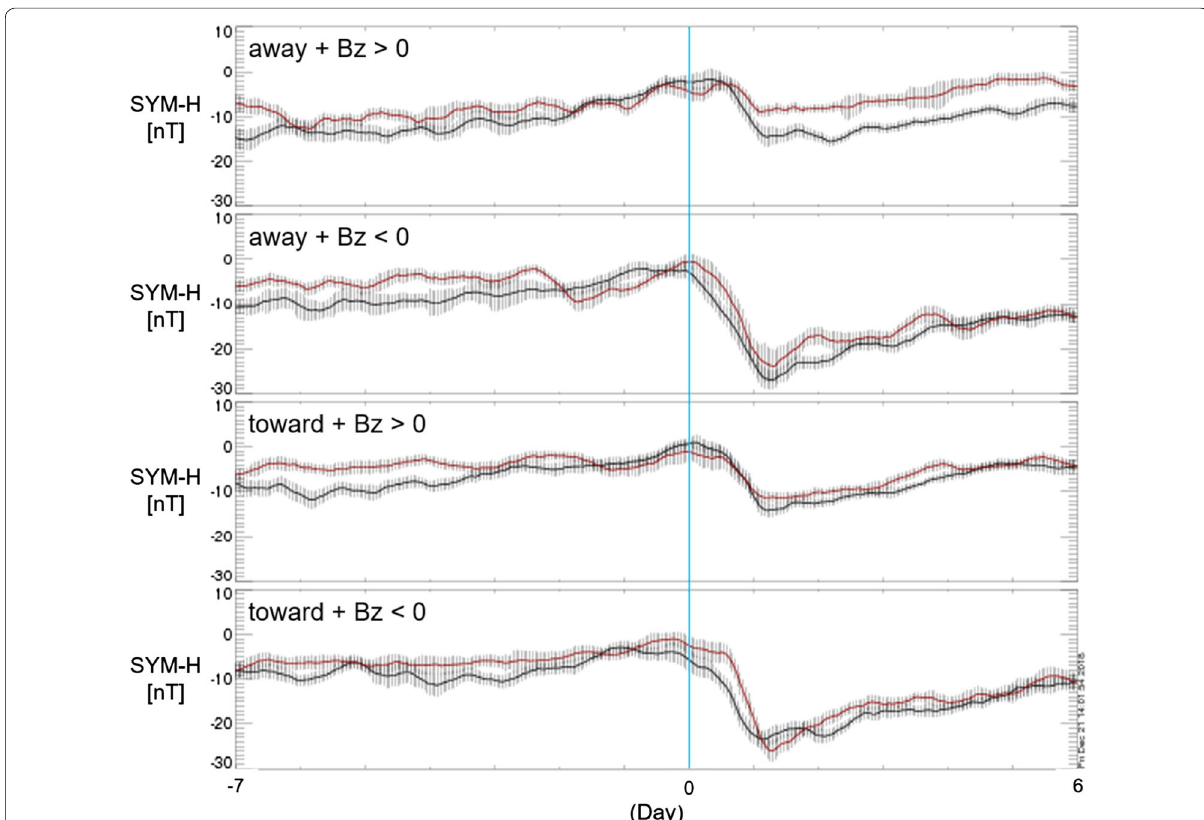
Fig. 12 The variation of SYM-H index for IMF cases for solar cycle 23 (black line) and for cycle 24 (red line). The vertical light blue line represents the start time of an enhancement of solar wind velocity around the Earth’s orbit. The error bar represents the standard